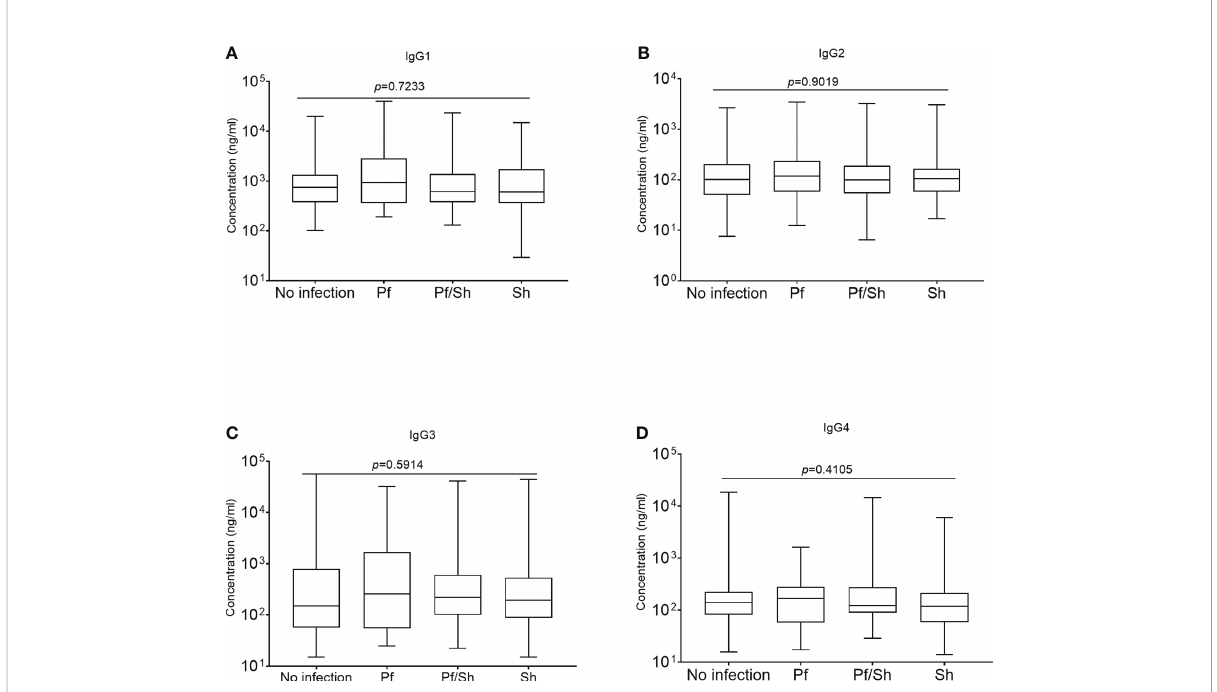
FIGURE 5 Schistosoma haematobium infection and plasma levels of GMZ2-speci fi c IgG subclasses. Plasma levels of anti-GMZ2 IgG1-4 presented as a box plot with the whiskers of each box indicating the minimum and maximum antibody levels as generated from Kruskal-Wallis analysis on rank variance, which reveals no statistical differences among the groups. Levels of IgG1, IgG2, IgG3 and IgG4 in the various groups are presented in plots (A – D) ,